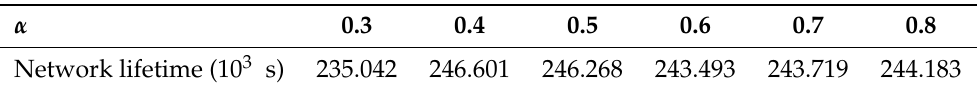
Table 8. The impact of α on the network lifetime.